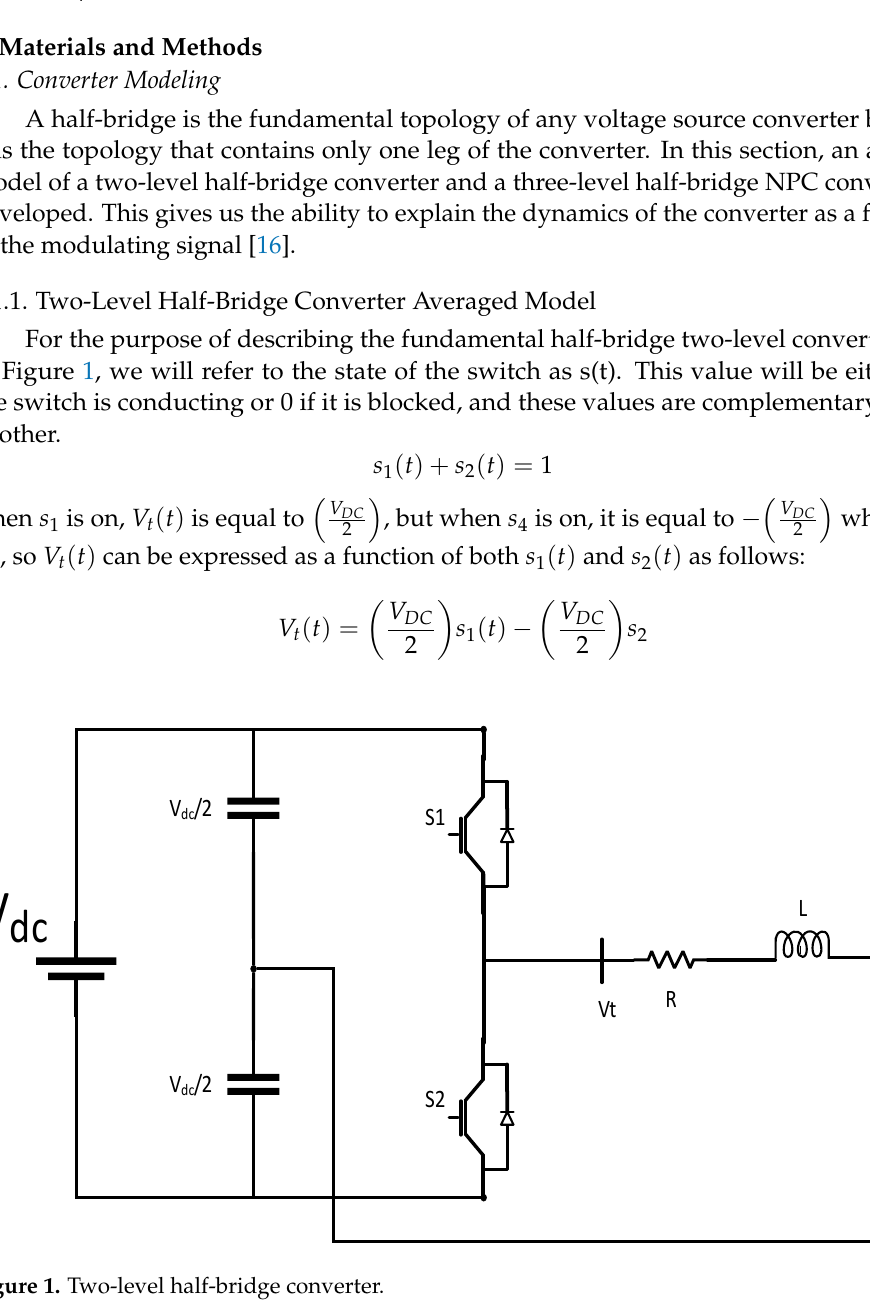
Figure 1. Two-level half-bridge converter.